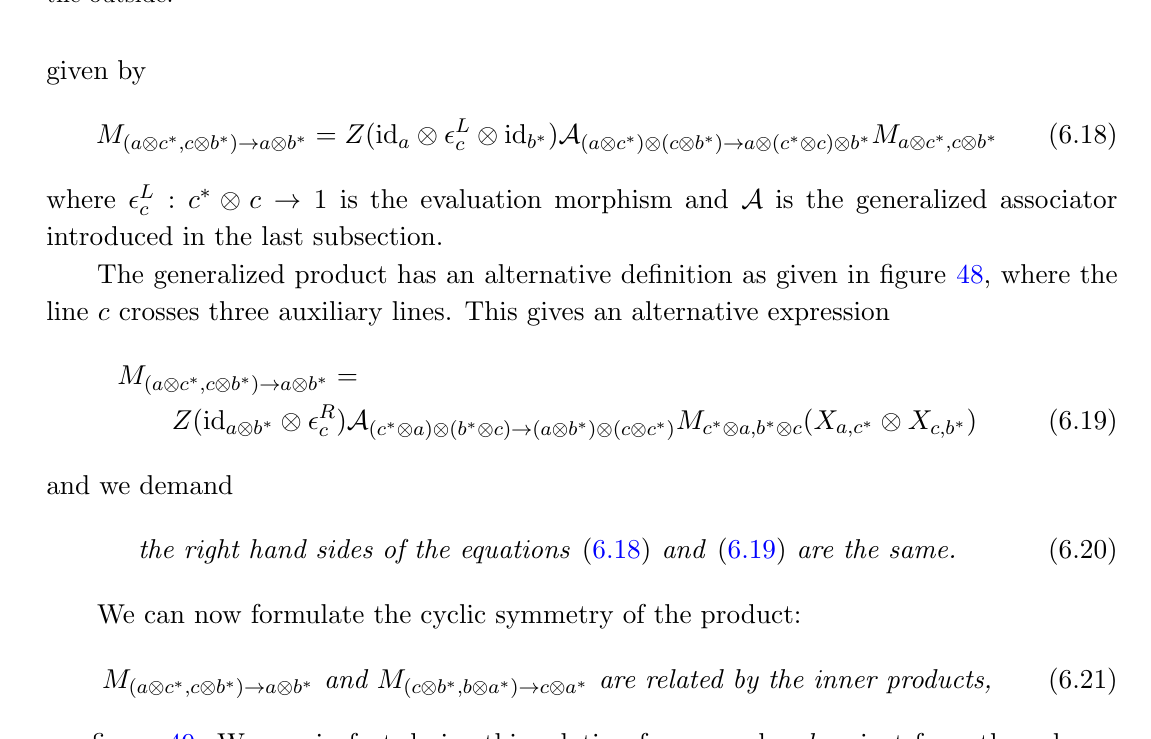
Figure 48 . An alternative de(cid:12)nition of the generalized product. The time (cid:13)ows from the inside to the